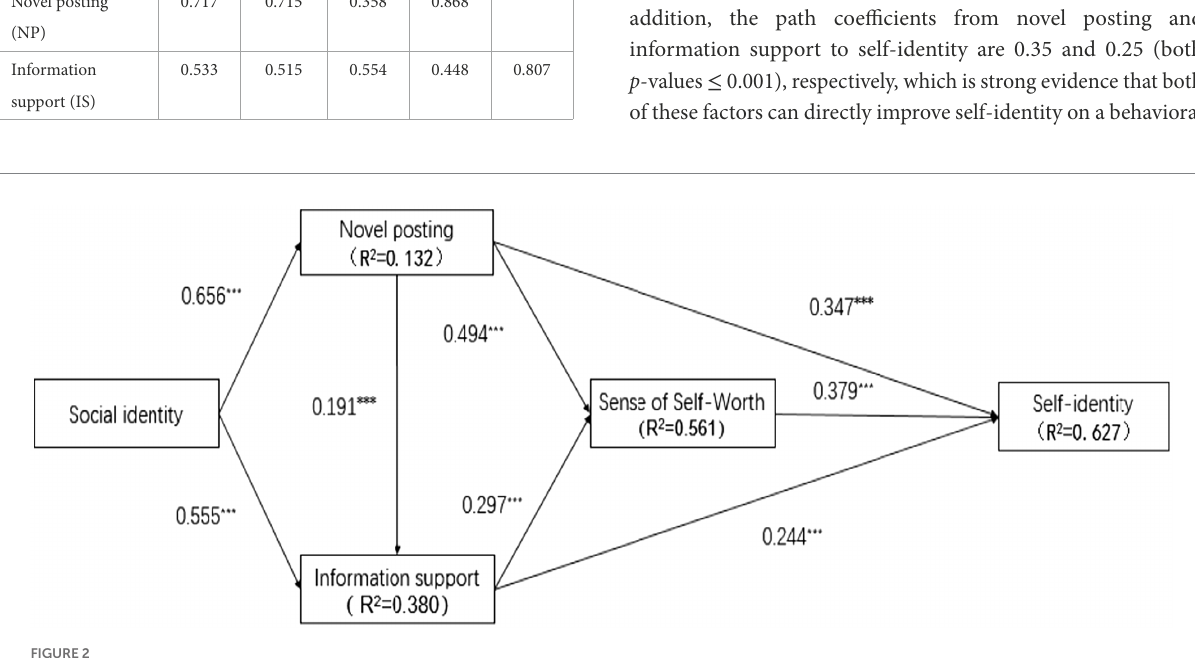
FIGURE 2 Model testing results (*** p <